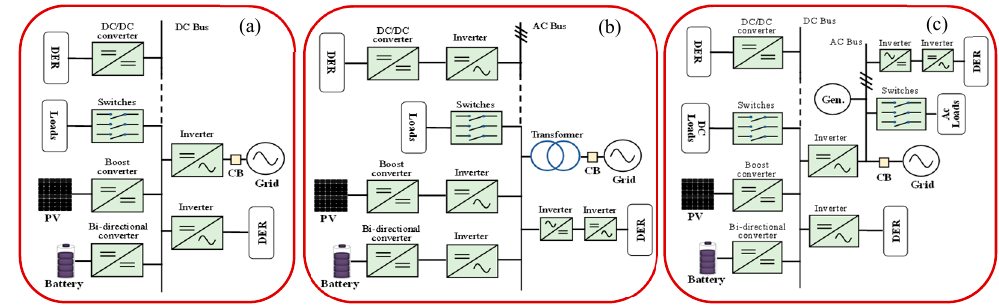
Figure 3. Block diagram examples of: ( a ) DC, ( b ) AC, and ( c ) hybrid microgrids.